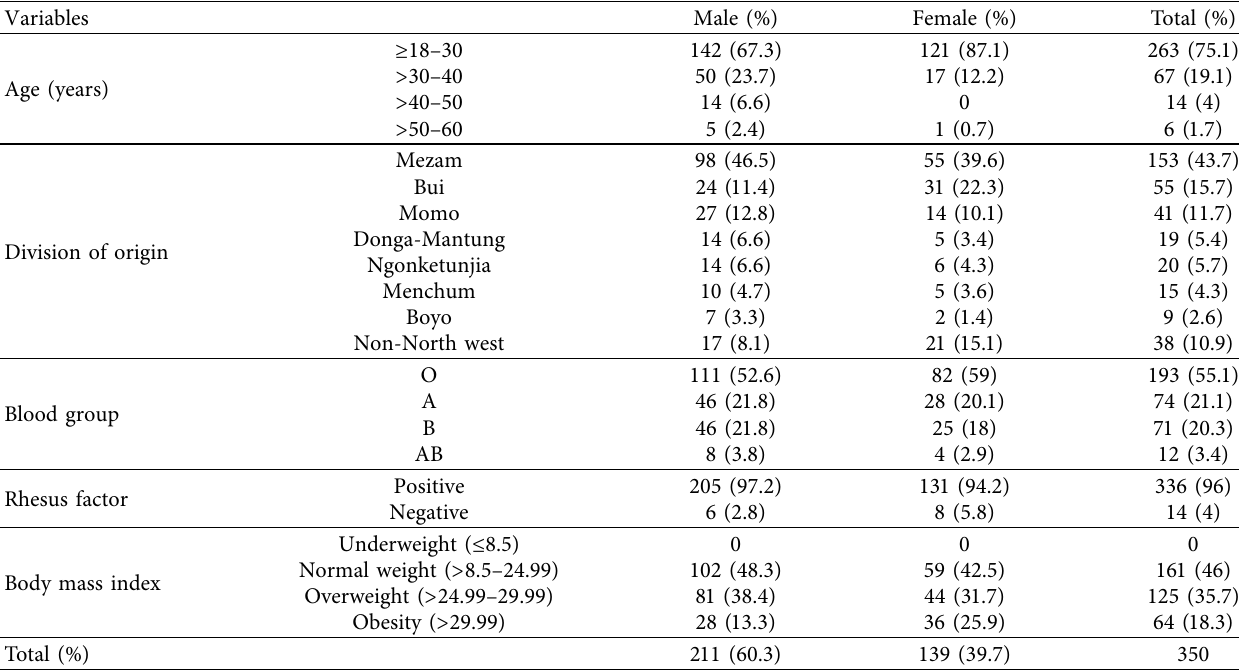
Table 1: Sociodemographic factors, blood group, and body mass index of the study participants. Variables